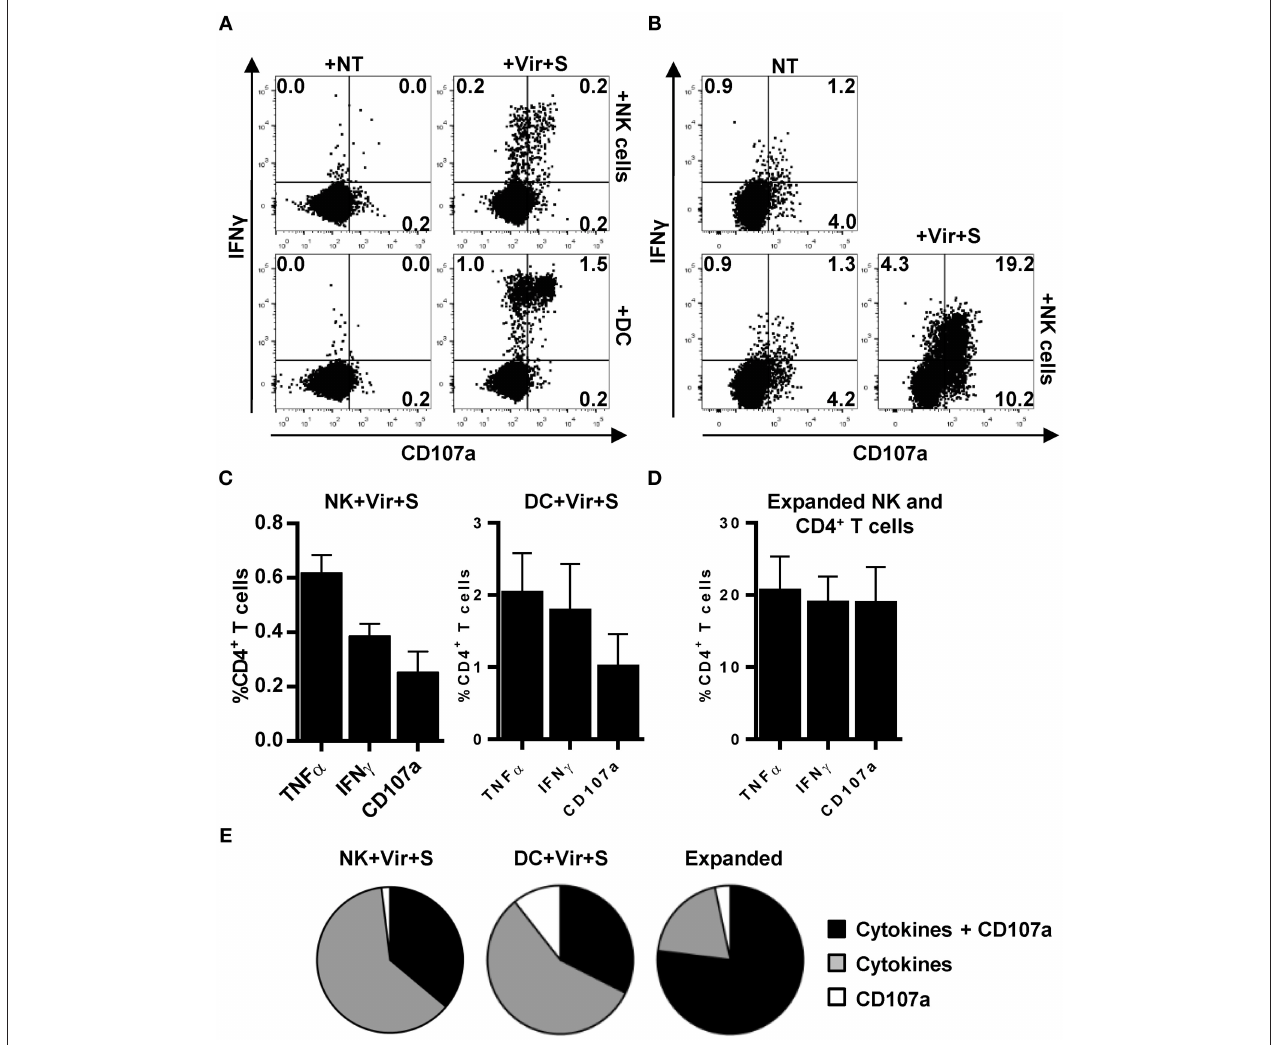
FIGURE 7 | Primary and expanded HCMV-specific CD4 + T cells degranulate in response to antigen loaded NK and moDC. TNF α and IFN γ production concomitant to CD107a mobilization was monitored by flow cytometry in co-culture experiments combining HCMV-loaded primary NK cells or moDC with primary autologous CD4 + T cells (A,C,E) or, alternatively, antigen loaded expanded NK cells and HCMV-expanded CD4 + T cells (B,D,E) . (A,B) Dot plots displaying the proportions of IFN γ + CD107a + CD4 + T cells in the primary (A) and expanded (B) experimental systems. Data from a representative experiment. (C,D) Proportions of TNF α + , IFN γ + , and CD107 + CD4 + T cells in the different experimental systems assayed (mean + SEM; n = 4). (E) Pie charts showing the distribution of CD4 + T cells that produce cytokines and degranulate against HCMV-loaded APC in the indicated experimental systems (mean; n =